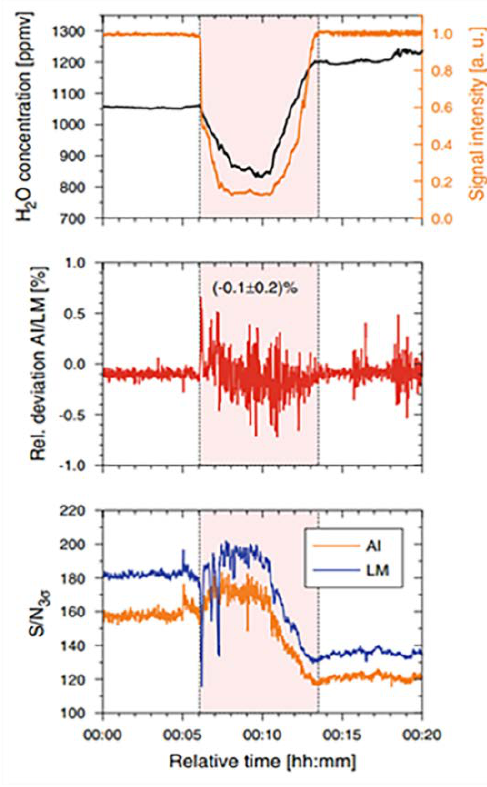
Figure 12. Comparison of AI fit and LM fit with relative time. This figure was obtained from [51].